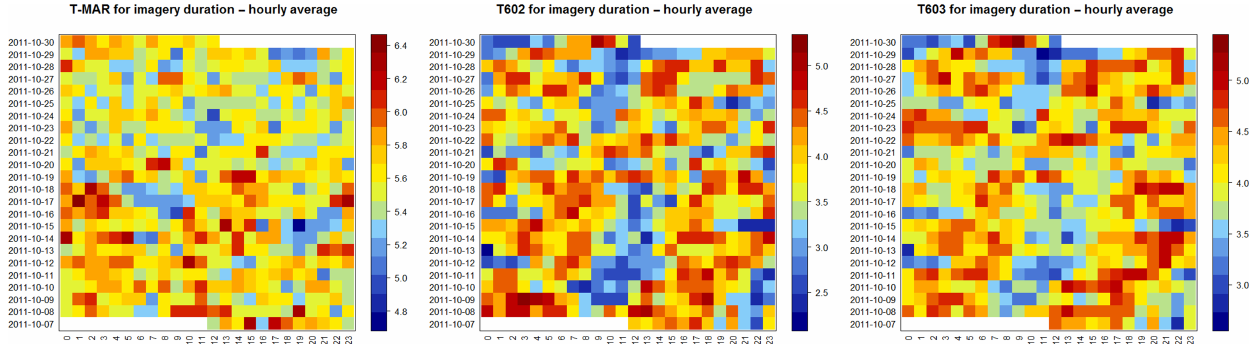
Figure 6. Hourly temperature values ( ◦ C) for T602 and T603 probes from NEP and the MAR temperature probe. Red indicates higher temperatures while blue represents the lowest temperatures. Dates correspond to the duration of the imagery analyses (23 days).